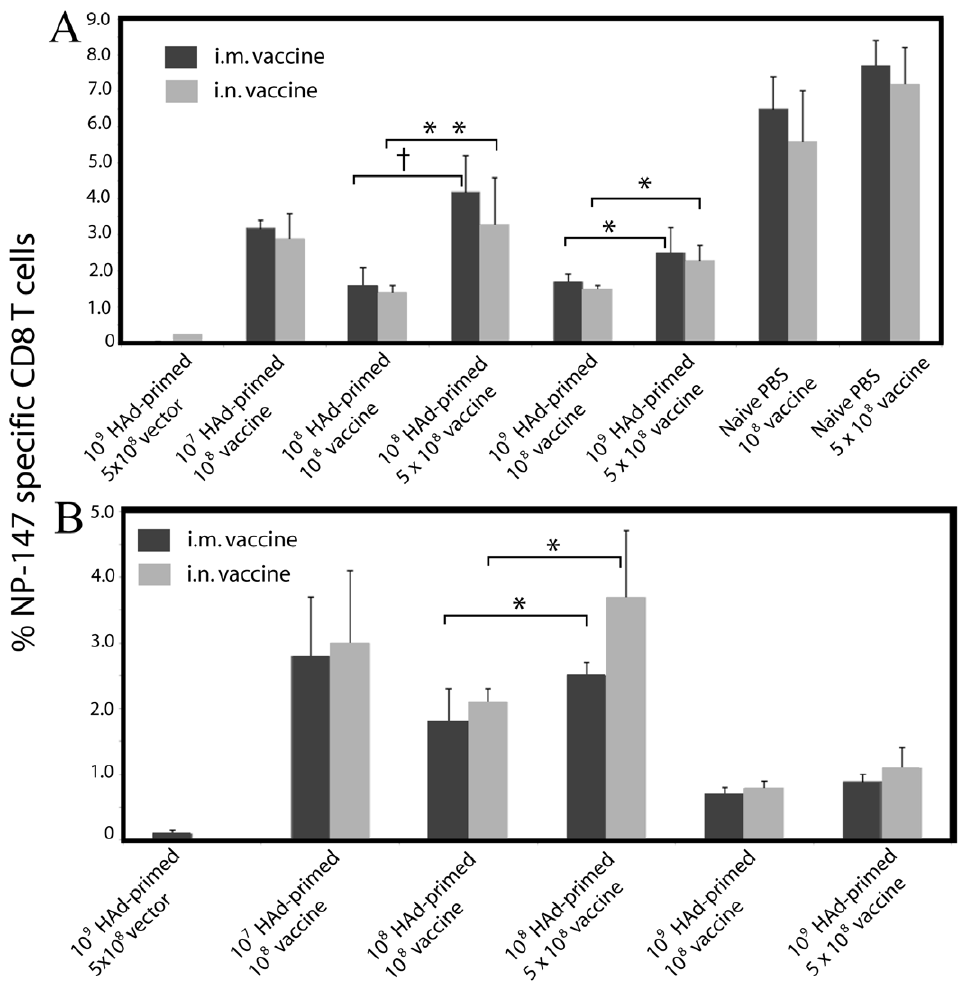
Figure 3. NP-147 epitope-specific CD8 + T cells in naı¨ve or HAd5-primed mice immunized with HAd-HA-NP. Naı¨ve or HAd-primed mice were immunized as described in the Materials and Methods. At four weeks after final immunization, animals were euthanized, and the spleens were collected. Single cell suspensions were prepared by passage through screens, and 1 6 10 6 cells were stained with a murine MHC-encoded allele k d – specific pentamer for immunodominant NP-147 epitope-conjugated with phycoerythrin (PE) and also with anti-CD8 antibody-conjugated with allophycocyanin (APC) and anti-CD19 antibody-conjugated with flouro-isothiocyanin (FITC). Flow cytometeric analysis was done to identify the number of NP-147-specific CD8 + T cells. Data were collected using BD FACSCanto II ( BD Bioscience , CA) and FACSDiva software was used for analysis. Data from five mice/groups are shown. (A) Percentage of NP-147-specific CD8 + T cells in intranasally primed groups. (B) Percentage of NP-147-specific CD8 T cells in intramuscularly primed groups. The error bars represent Mean 6 SD from five animals/group: *, P # 0.05; **, P # 0.01; { , P # 0.001.